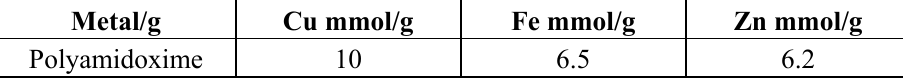
Table 1. Amount of metal loaded on the graft